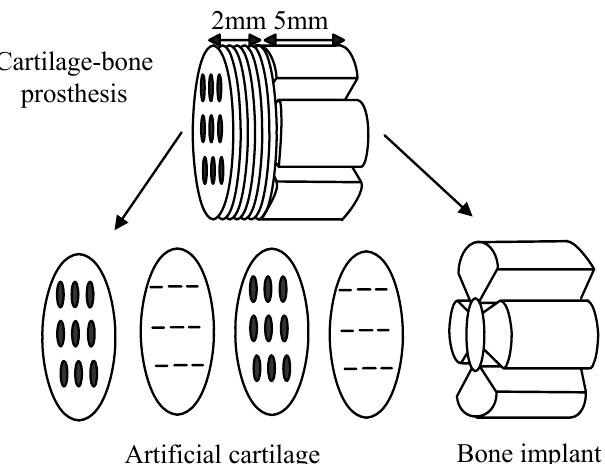
Figure 4. Schematic illustration showing a graded porous